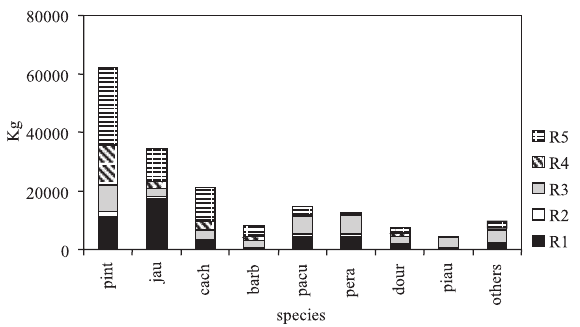
Fig. 4. Total landing of catch in kilograms by region (R1 = region 1; R2 = region 2; R3 = region 3; R4 = region 4; R5 = region 5) of the rio Cuiabá for each species (pint = pintado; cach = cachara; barb = barbado; pera = piraputanga; dour =